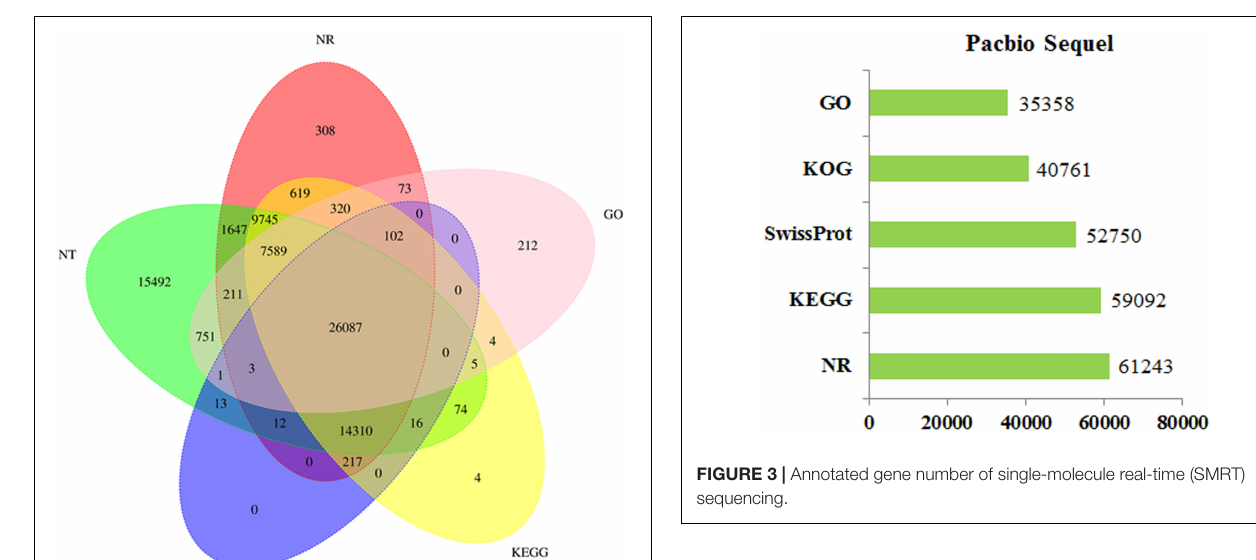
should be further annotated with updated published fish genes and related gene background information.